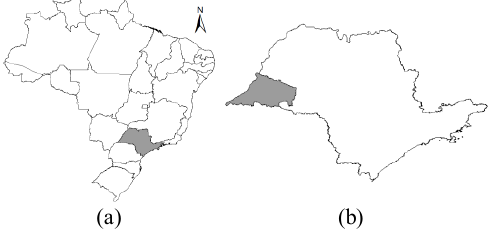
Figure 1. (a) São Paulo State and Brazil; (b) The West Region of São